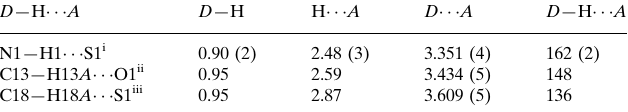
Hydrogen-bond geometry (A˚ , (cid:2)